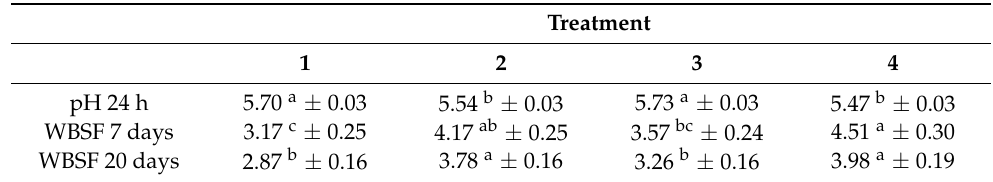
Table 3. pH at 24 h postmortem and Warner Bratzler shear force (WBSF) (kgF) after 7 and 20 aging days by treatment. Least square means ± standard error.